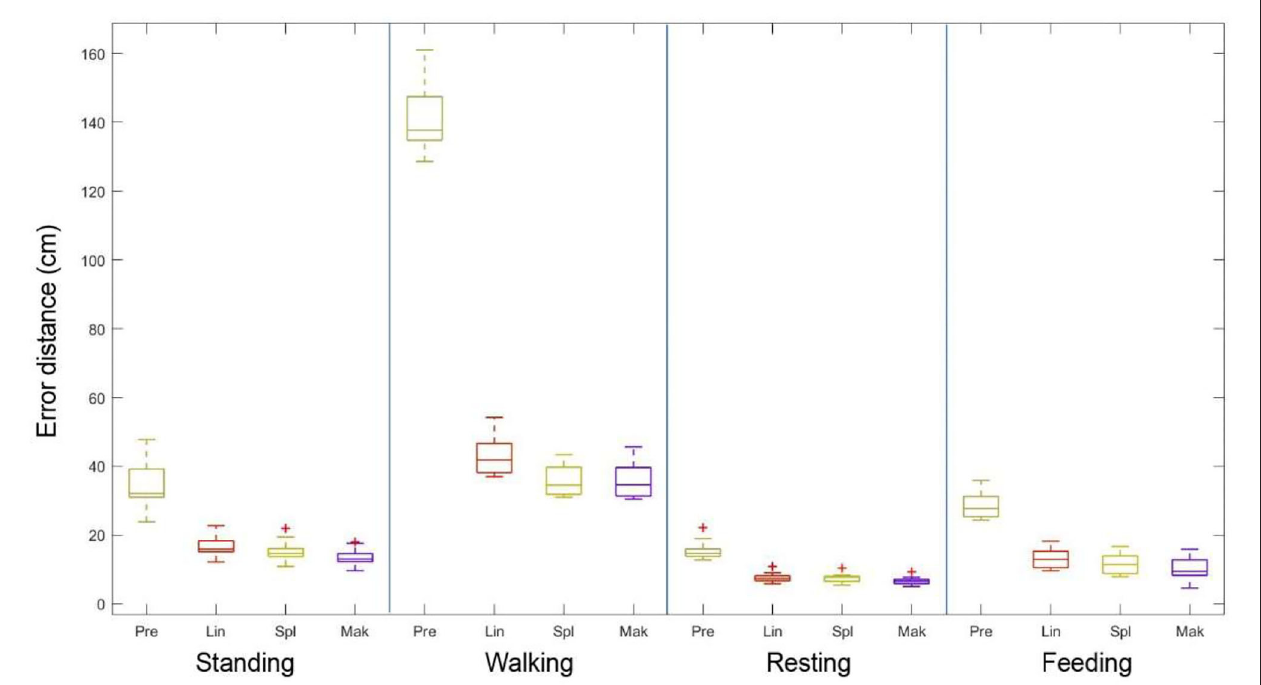
FIGURE 3 | The performance of the four interpolation methods for different activities. The error distances were the largest for animals walking, while they were the smallest for animals resting in the cubicle area. The modified Akima interpolation methods improved performance compared to using the previous position (Pre); the improvement was the largest when tracking individuals